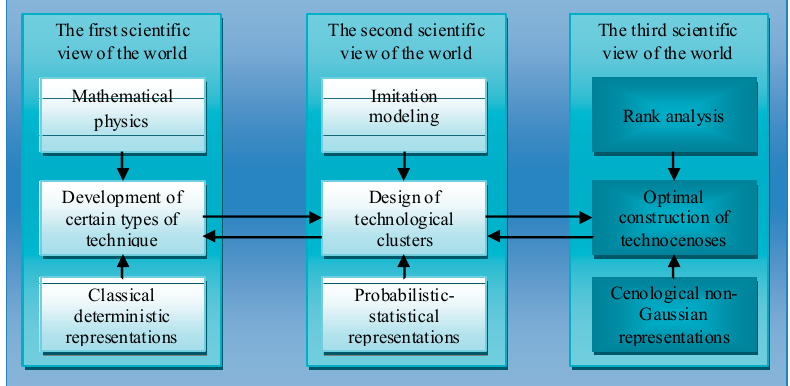
Figure 4. Methodological levels of understanding technical systems within three main scientific views of the world Ref. [96].